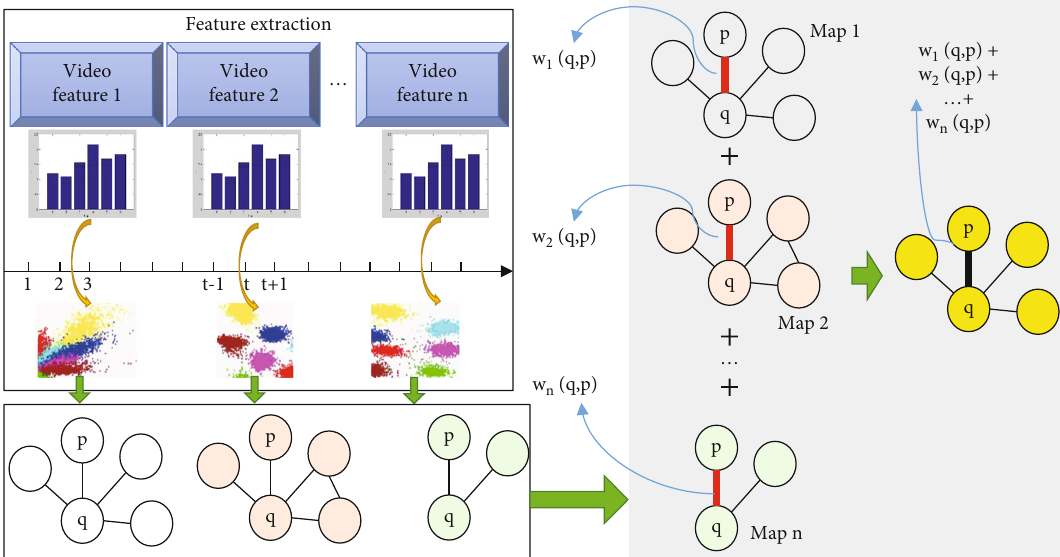
Figure 3: Multigraph fusion process.